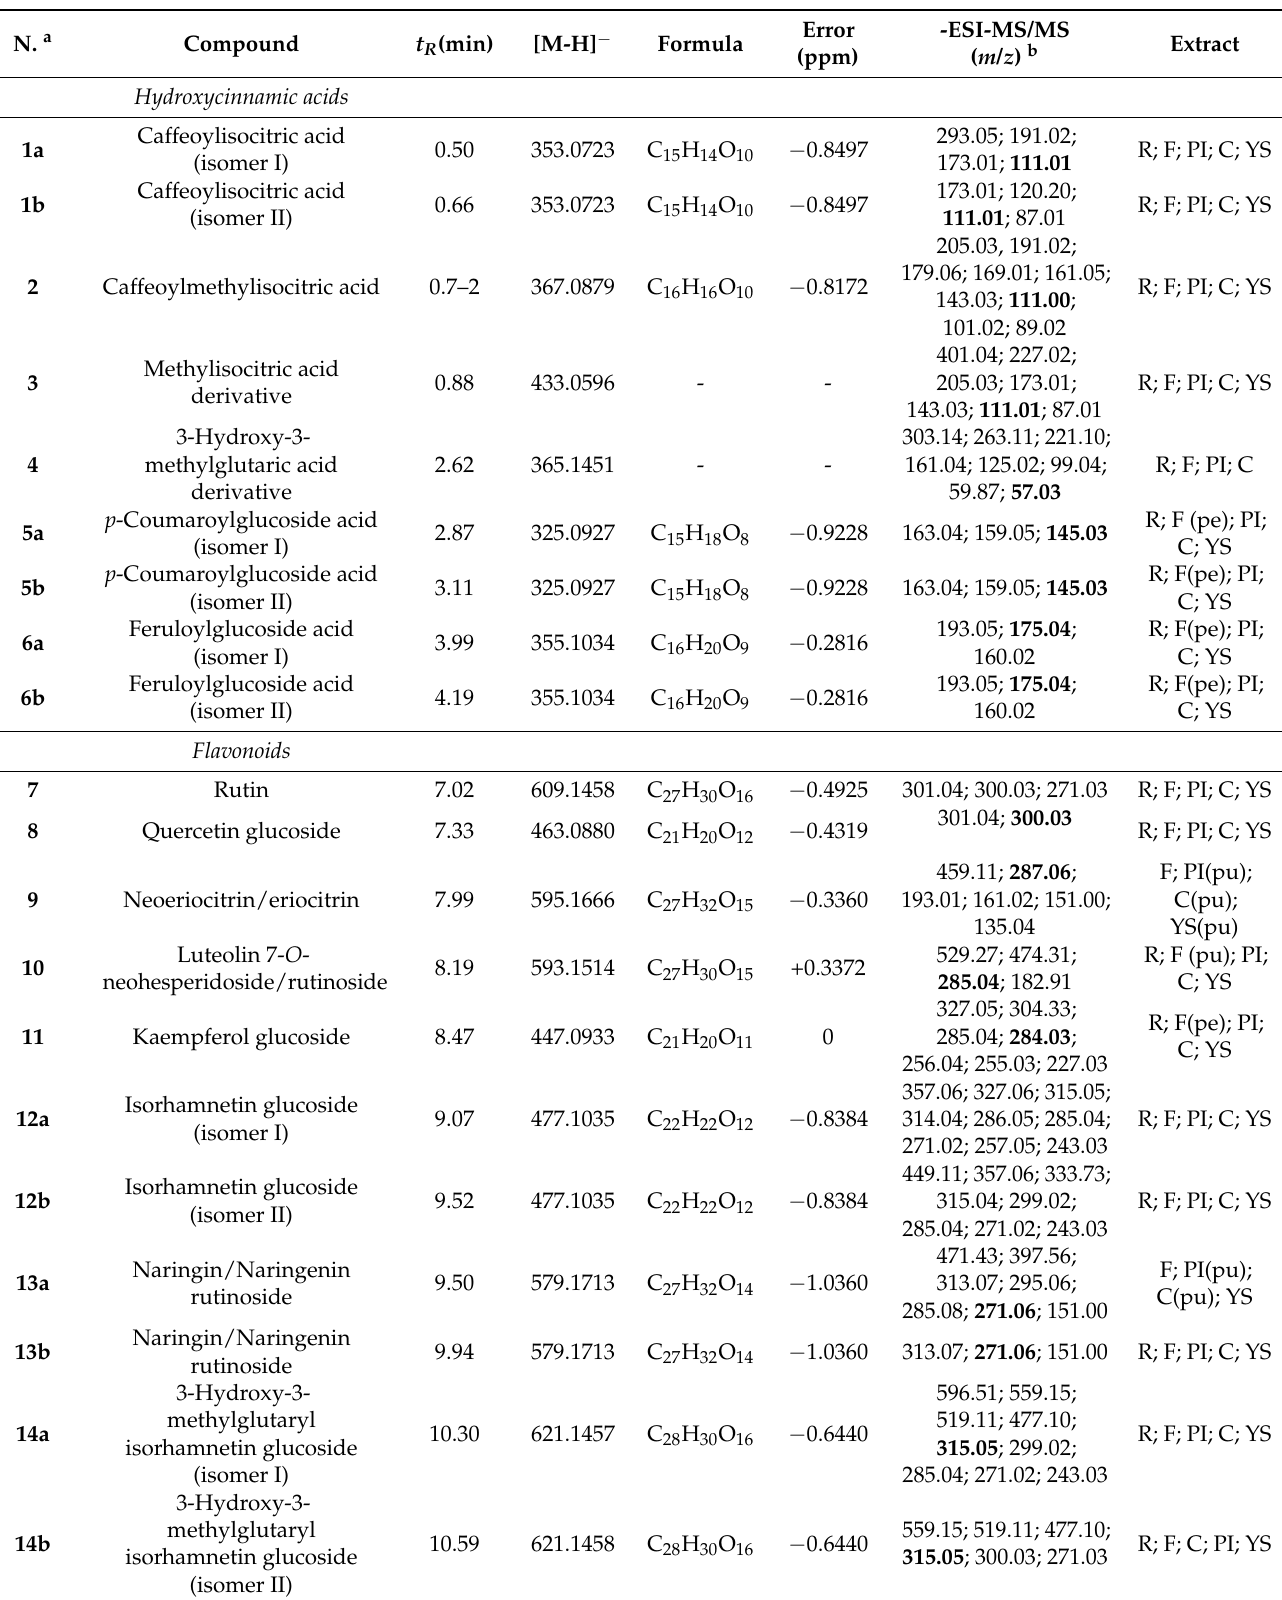
Table 2. Chromatographic data (retention time, t R ) and HR-ESI-MS/MS data of compounds 1–26 , detected in peels and pulps of Citrus australasica F. Muell. C = Collette; F = Faustrime ; PI = Pink Ice; R = Red; YS = Yellow Sunshine. pe = only peel; pu = only